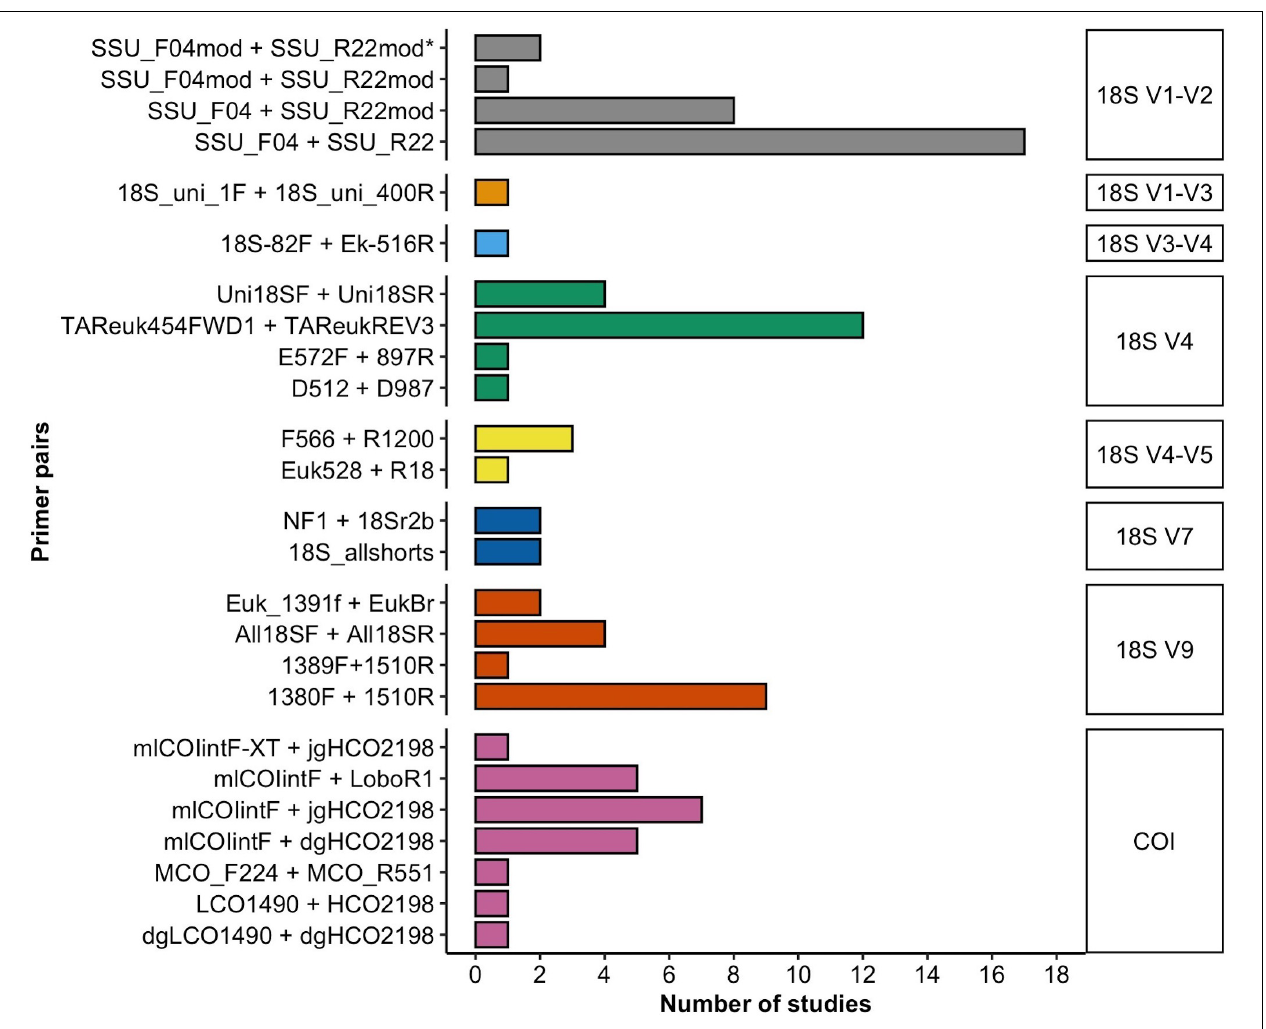
FIGURE 2 | A total of 18 and 7 primer combinations were used that amplify the different variable regions of the 18S rRNA gene or partial segments of the 5 (cid:48) end of the mitochondrial COI, respectively. Bars of primer pairs with a matching color target the identical molecular marker as indicated in the right margin of the